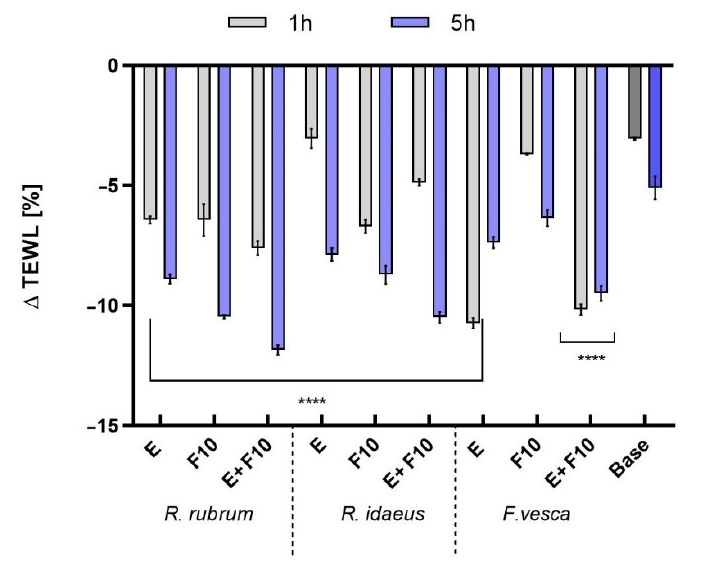
Figure 8. The influence of model skin tonics with R. rubrum, R. idaeus, and F. vesca extracts (E), ferments (F10), and extracts + ferments (E + F10) on transepidermal water loss (TEWL). Data are the mean ± SD of three independent measurements. **** p < 0.0001 compared to the base tonic.